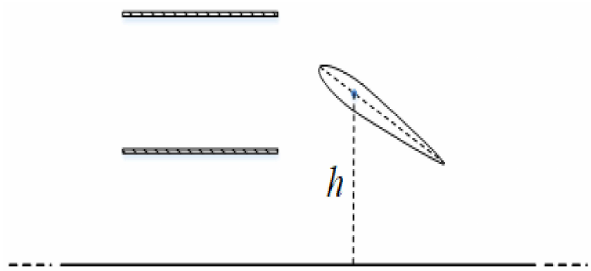
Figure 22. Diagram of ground